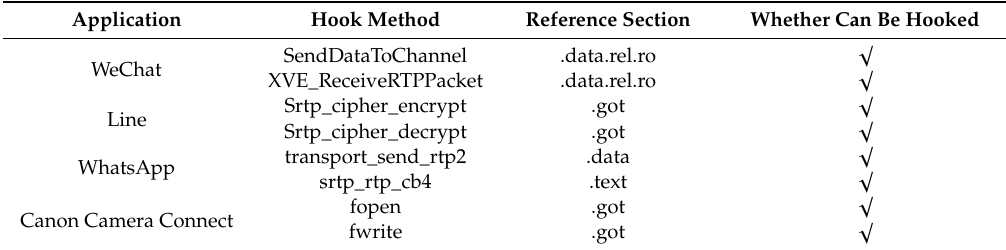
Table 1. Target methods of four